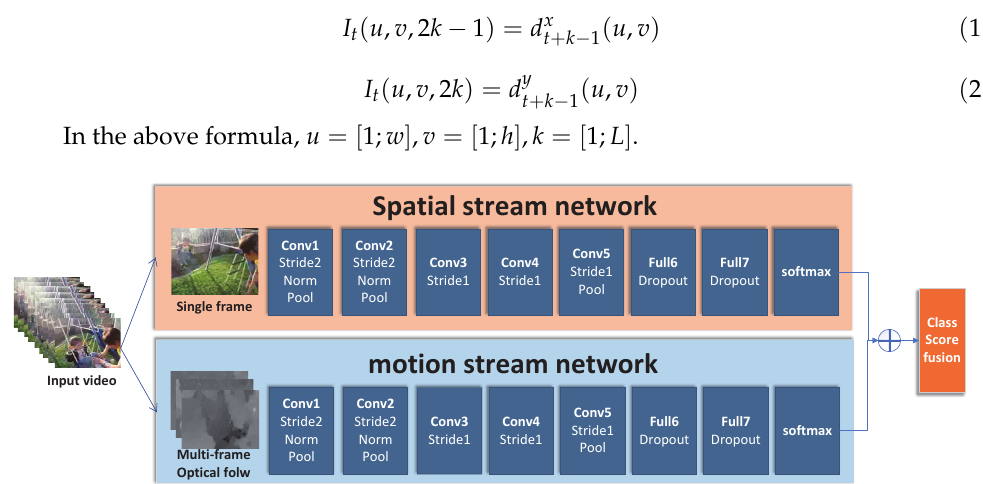
Figure 1. Classical two-stream convolution network